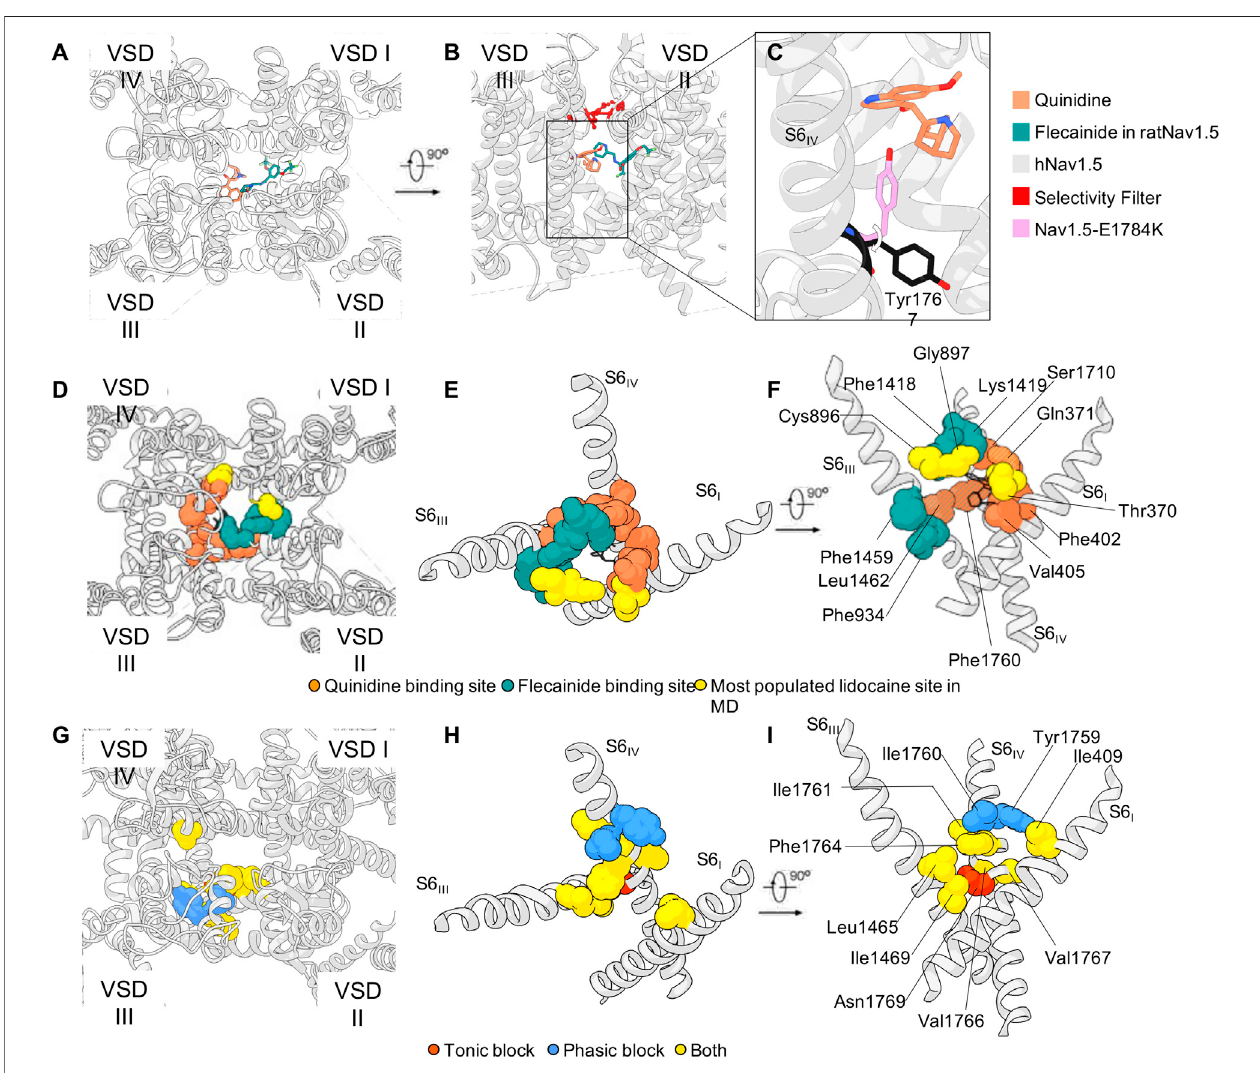
FIGURE5| LAsbindingsites. (A,B) QuinidineinhNav1.5and fl ecainidebindingposesinrNav1.5(PDBIDs:6LQAand6UZ0,respectively)and (C) quinidine ’ seffect on therotationTyr1767, asobservedinhNav1.5 (PDB ID:7DTC). (D – F) Sphererepresentation oftheresiduesthatappear inthebindingsite ofquinidine(black